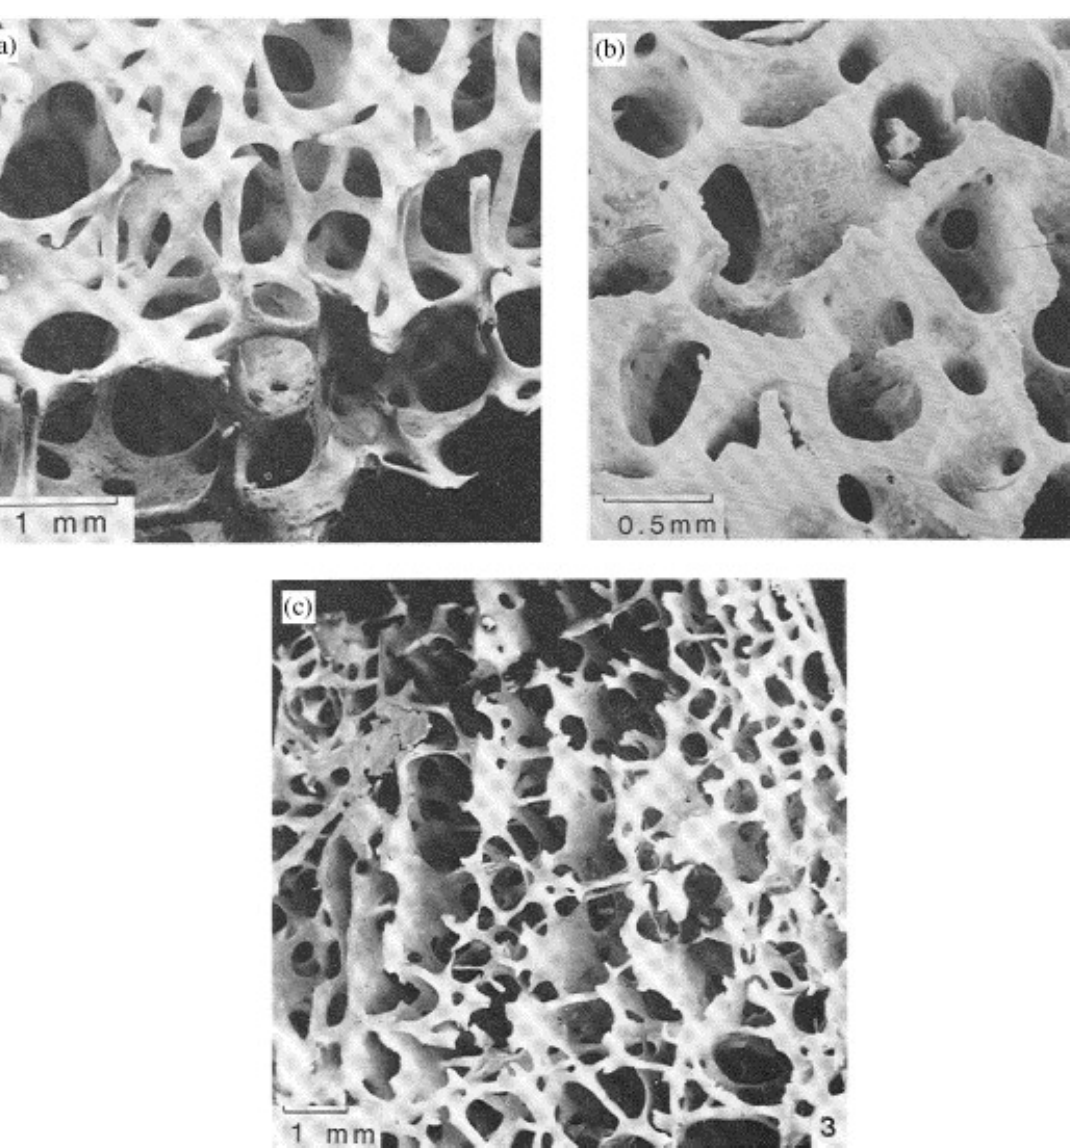
Figure 6. Scanning electron micrographs showing the cellular structure of trabecular bone. (a) Specimen taken from the femoral head, showing low-density, open-cell, rod-like structure. (b) Specimen taken from the femoral head, showing a higher density, perforated plate-like structure. (c) Specimen taken from the femoral condyle, of intermediate density, showing an oriented structure, with rods normal to parallel plates. Figure reprinted from reference [138] with permission of